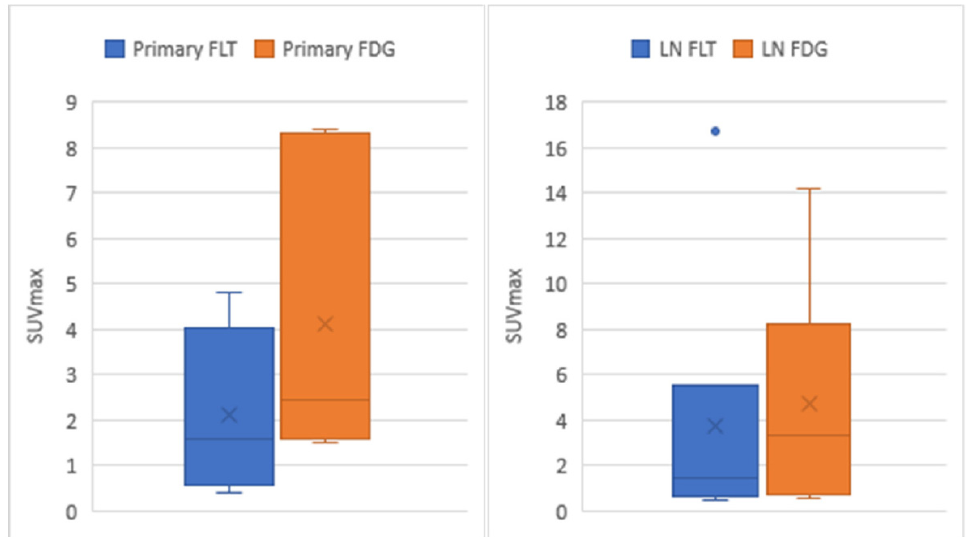
Figure 4. Boxplots of the SUVmax for treatment-naive patients (patients 1–6). SUVmax, maximum standardized uptake value; primary FLT, SUVmax of the primary breast cancer on 18 F-fluorothymidine positron emission tomography/computed tomography ( 18 F-FLT PET/CT); primary FDG, SUVmax of the primary breast cancer on 18 F-fluorodeoxyglucose positron emission tomography/computed tomography ( 18 F-FDG PET/CT); LN FLT, SUVmax of the axillary lymph node on 18 F-FLT PET/CT; LN FDG, SUVmax of the axillary lymph node on 18 F-FDG PET/CT.